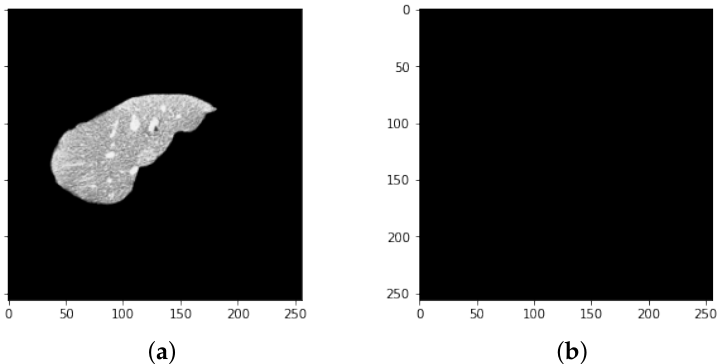
Figure 13. Results of the proposed model ( a ) liver segmentation and ( b ) tumor segmentation (without